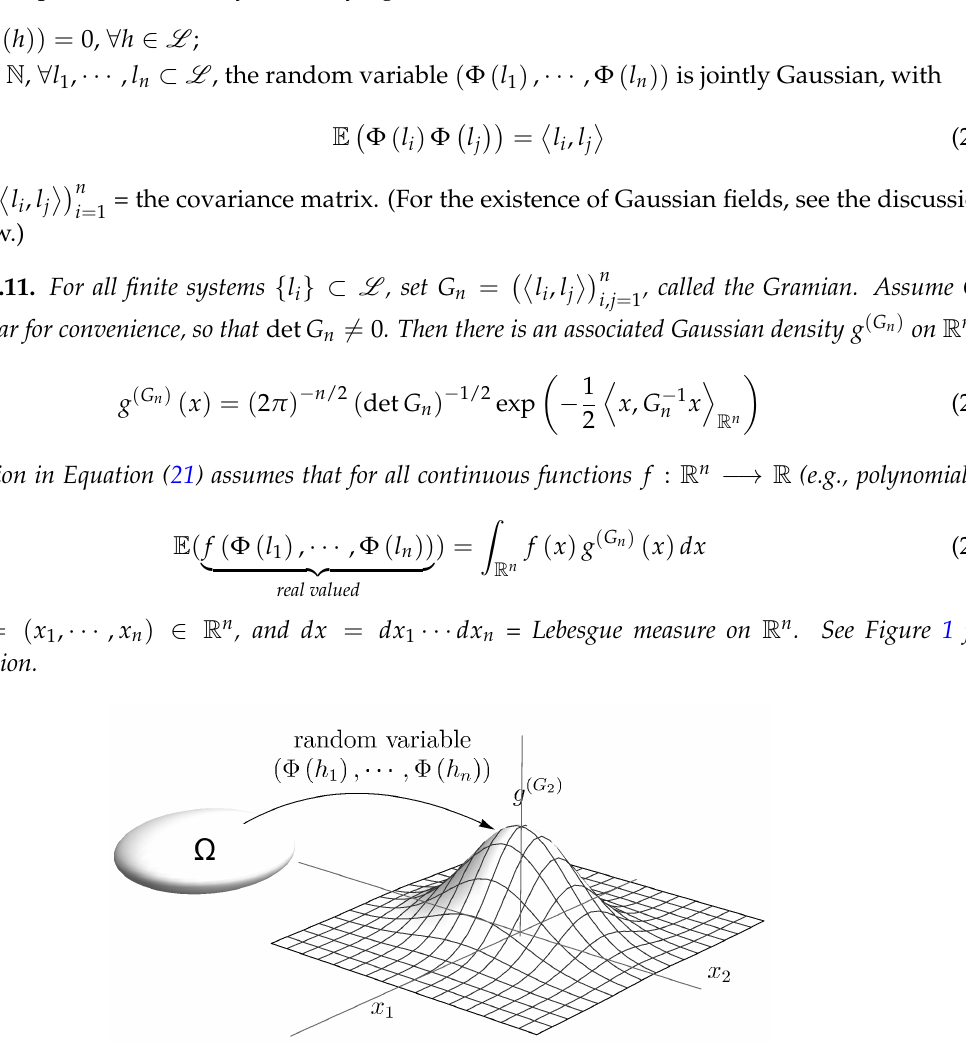
Figure 1. The multivariate Gaussian ( Φ ( h 1 ) , · · · Φ ( h n )) and its distribution. The Gaussian with Gramian matrix (Gram matrix) G n , n =